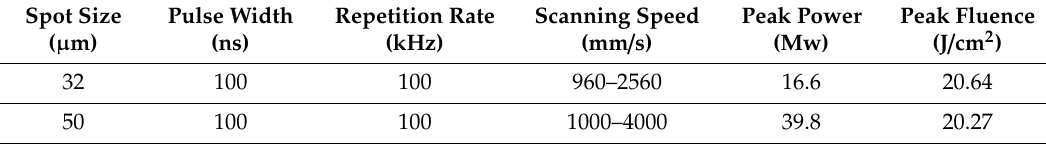
Table 2. Laser parameters for the study of the focal spot size and the pulse overlap’s